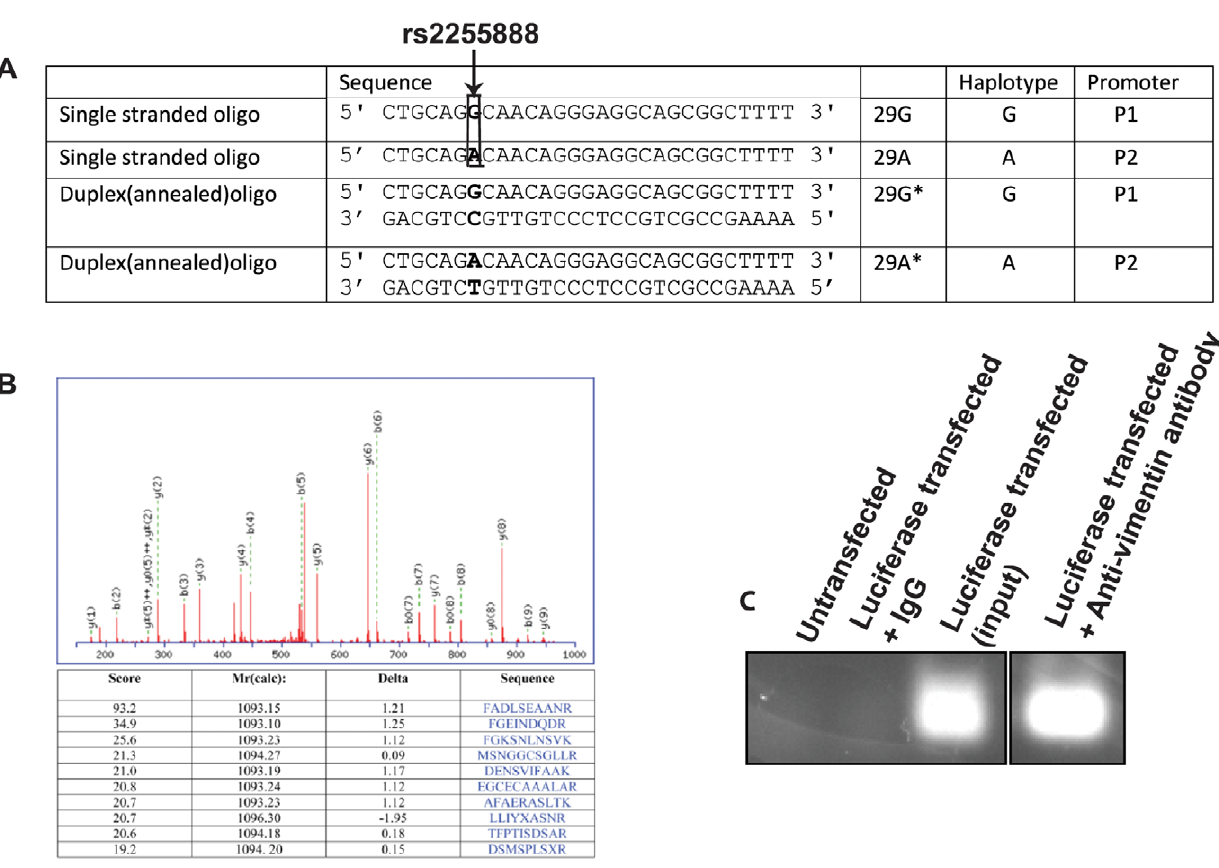
Figure 1. In vitro and In vivo Binding of Vimentin to Human ALOX15 Promoter Variants. ( A ) Oligonucleotide sequences used for the gel shift assay experiments corresponding to promoters P1 and P2, which differ at rs2255888 (indicated by arrow). ( B ) Identification and analysis of Vimentin, from magnetic bead DNA-protein pull-down assay, by LC-MS/MS. Proteins were identified by database search of the fragment spectra against the National Center for Biotechnology Information nonredundant protein database (NCBInr) using Mascot (version 2.2, Matrix Science, London, UK). The sequence match for one of the assigned peptides is shown with the fragment ions identified as y(n), b(m) to indicate the y and b ions, respectively. The table shows the top-ranked peptide match and the scores for the next 9 for that spectrum. ( C ) Chromatin immunoprecipitation (ChIP) assay of P1 luciferase transfected NIH3T3 cells with anti-vimentin antibody (C20).